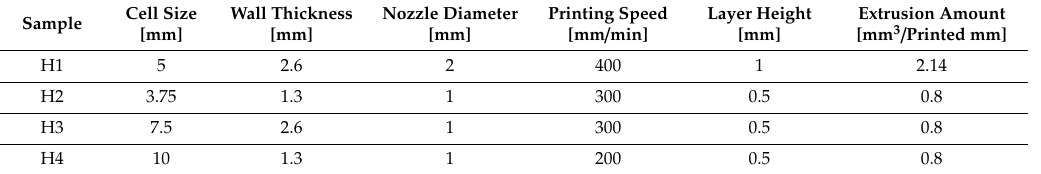
Table 4. Printing parameters used to 3D print the experimental samples.